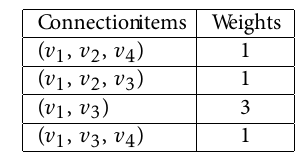
Figure 6. The connectionsbetweena 4-node DSF witha LEO satellite. Table 2. The weightsofconnectionitemsin a DSF with4